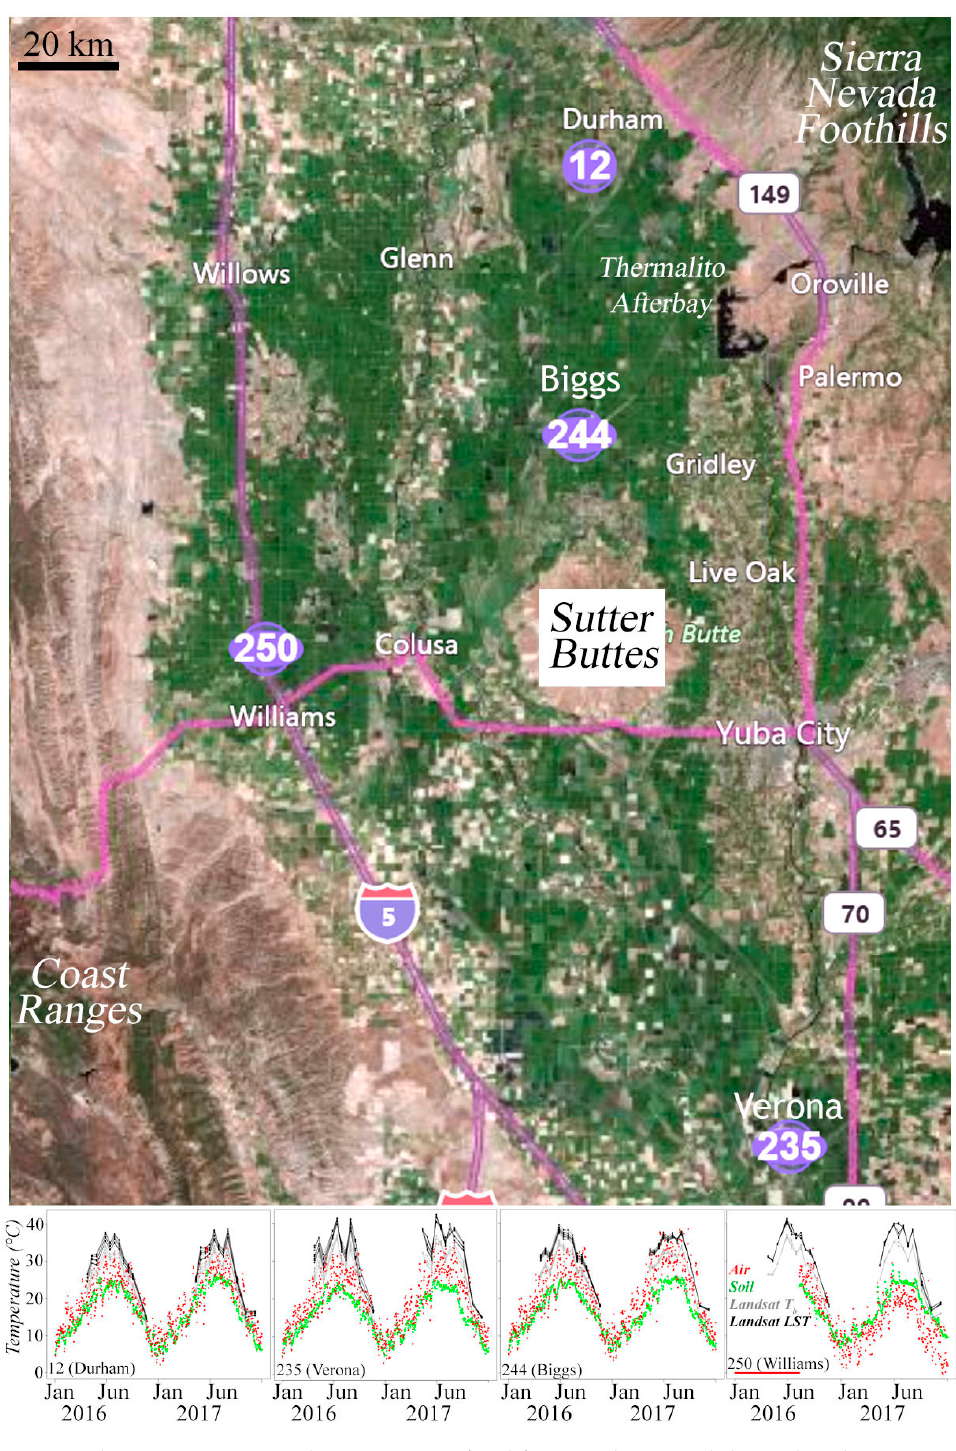
Figure 3. The primary rice producing region of California. The annual thermal cycle is captured by 4 met stations maintained by the California Irrigation Management Information System (CIMIS). Air temperatures (red) are generally higher and more variable than soil (green). Durham, Verona, & Biggs records are similar. The Williams station (installed mid 2016) has substantially lower air, but similar soil and brightness temperatures, to the other stations. Landsat T b (black) generally records at the warm bound of the envelope of air T. Landsat LST is higher than T b in all cases.